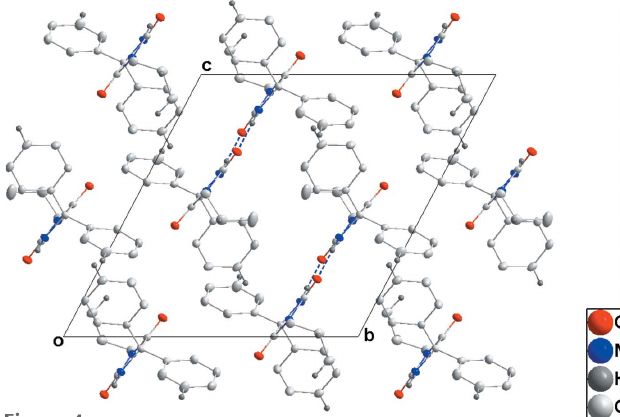
Figure 4 Packing viewed along the a -axis direction with intermolecular inter- actions depicted as in Figs. 2 and 3.